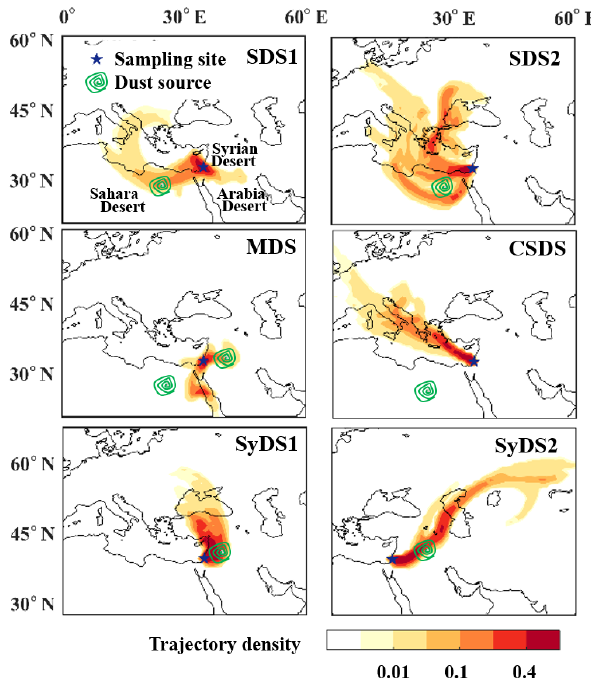
Figure 2. Air mass origin and atmospheric paths of the dust events. Colors represent the density of 72h backward air mass trajectories (normalized to the total trajectory counts). The green contours rep- resent the geographic locations where a high mass of dust occurred during the air mass transition, which is defined as the potential ori- gin of the dust. Abbreviations in the top right of each panel indicate the particular dust